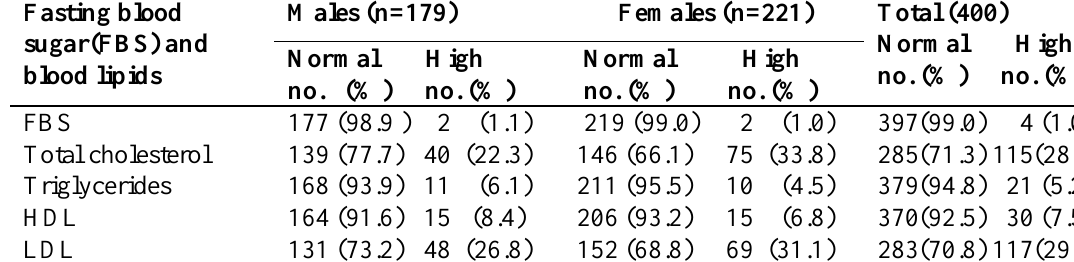
Table 3. Distribution of study population according to normal and high fasting blood sugar and lipid levels by sex.